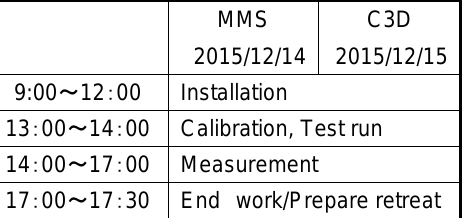
Table 2. Time schedule of the work